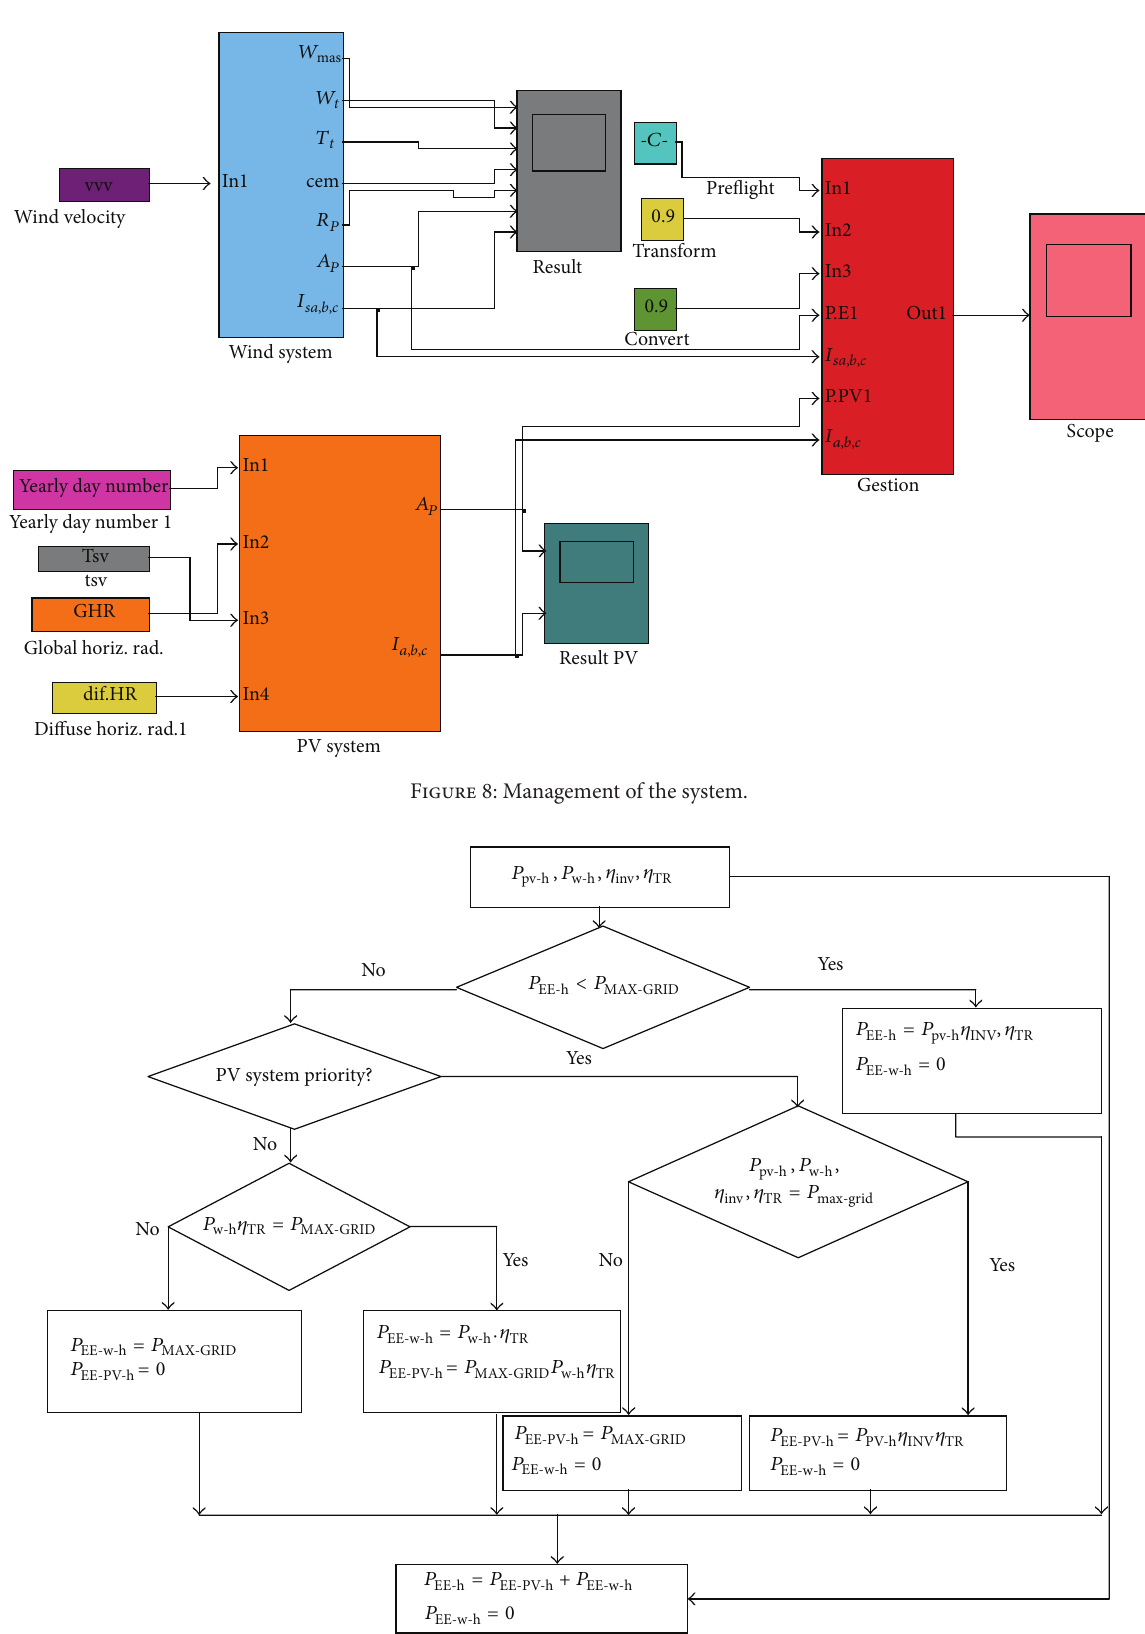
Figure 9: Flowchart for calculating the amount of power to be inject into the